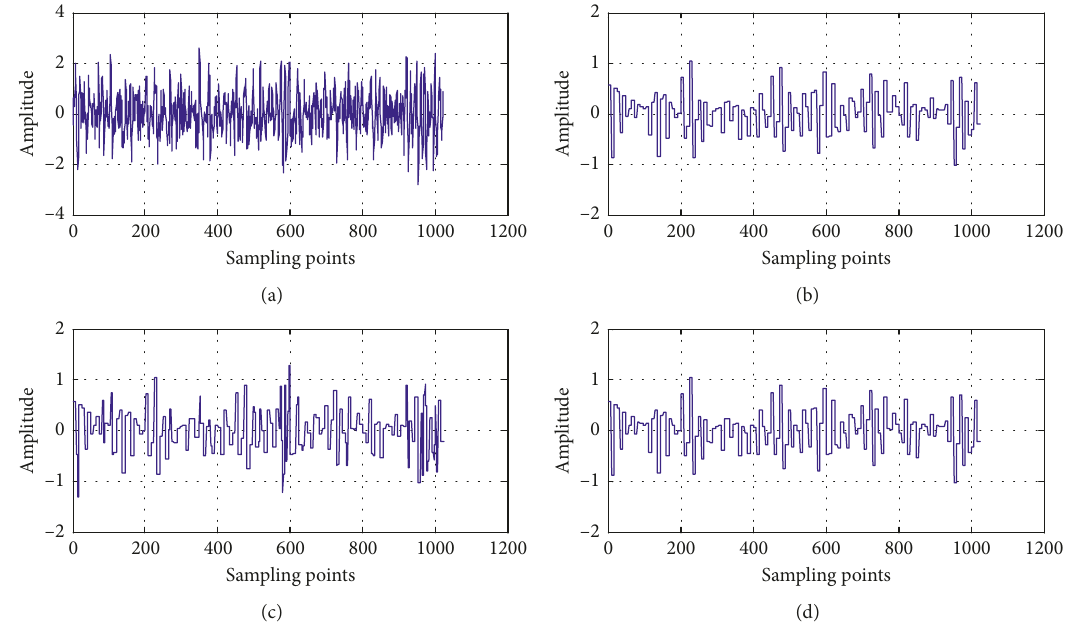
Figure 8: Normal operation signal and the waveform after denoising. (a) Normal operation signal. (b) Hard threshold denoised signal. (c) Default threshold denoised signal. (d) Given soft threshold denoised